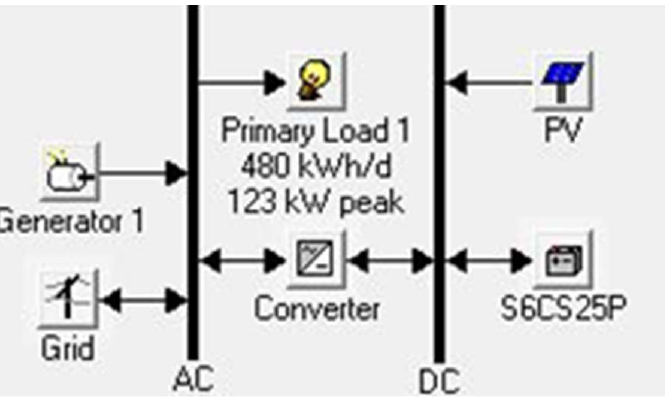
Figure 3. On-grid Scenario: generating system.